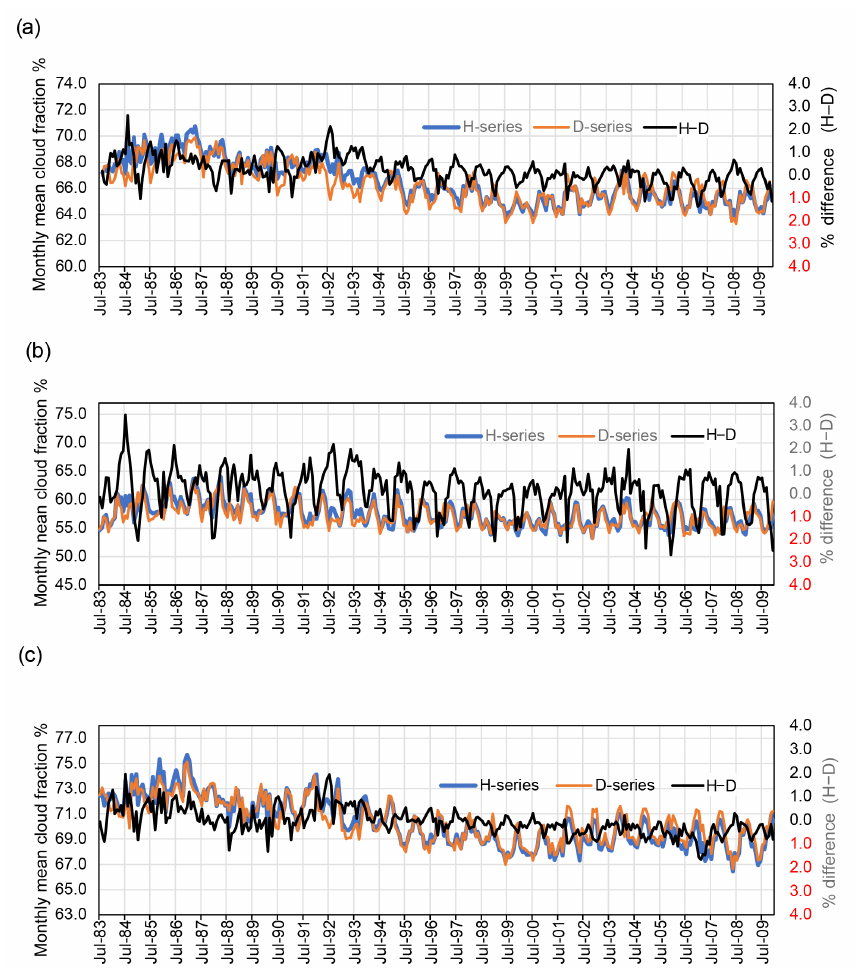
Figure 4. Comparison of ISCCP H- (blue) and D-series (orange), and differences between H- and D-series (black) monthly mean cloud fraction (%) for (a) total (land and water), (b) land only, and (c) water only. For the secondary vertical axes, black numbers represent positive differences and red numbers are negative. Data are for July 1983 through December